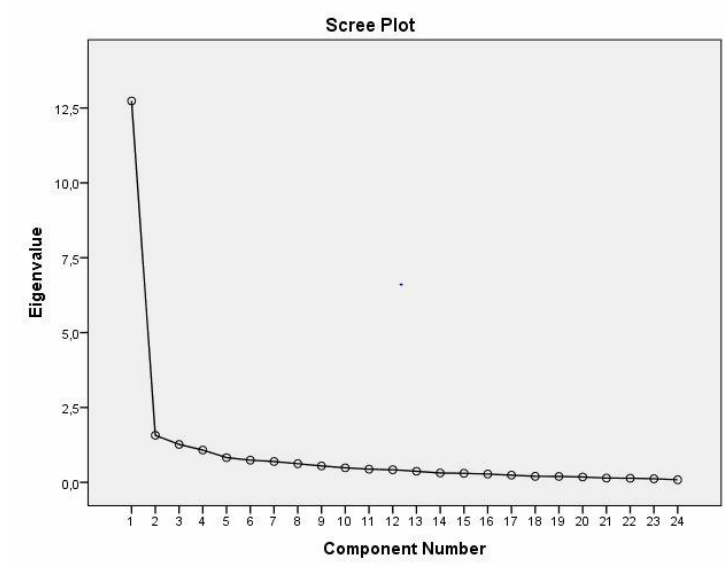
Figure 1. Scree plot extracted from the exploratory factor analysis of the Portuguese version of the CANHELP Lite Bereavement Questionnaire.